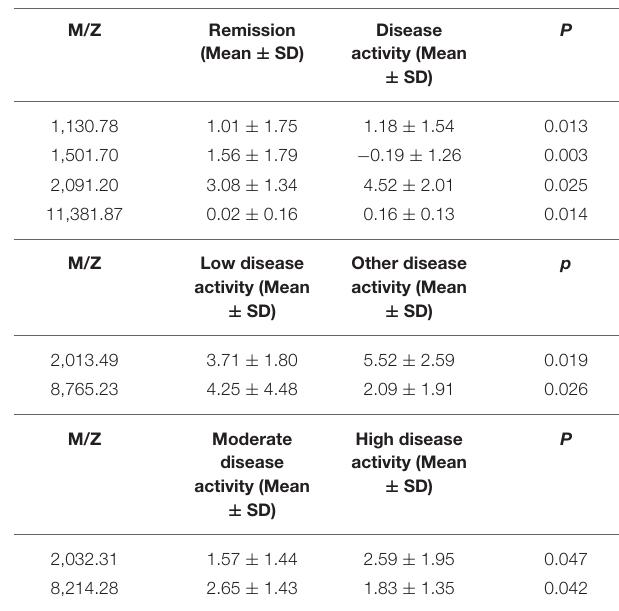
TABLE 4 | Biomarker statistics for assessing the activity of disease in RA